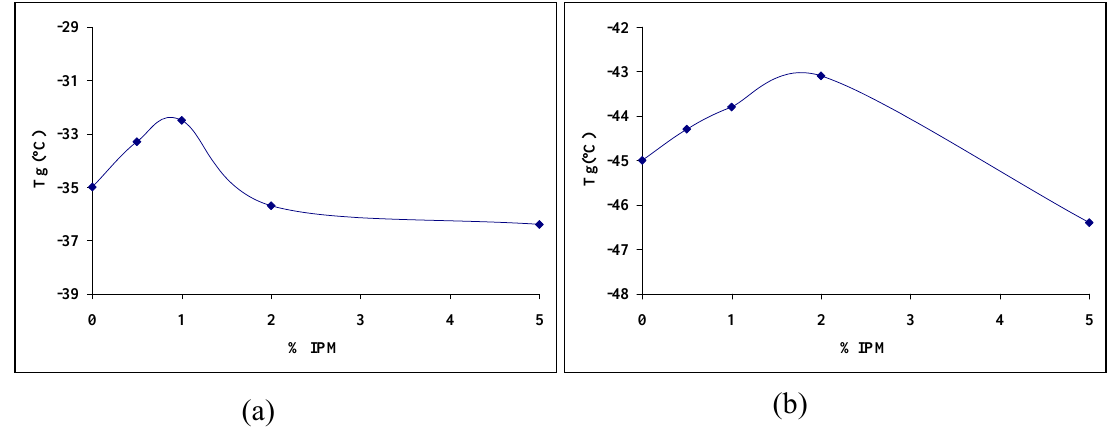
Figure 5. Glass transition temperature of (a) PEU-1 series (b) PEU-2 series (results of duplicate measurement by DMA, ±0.1